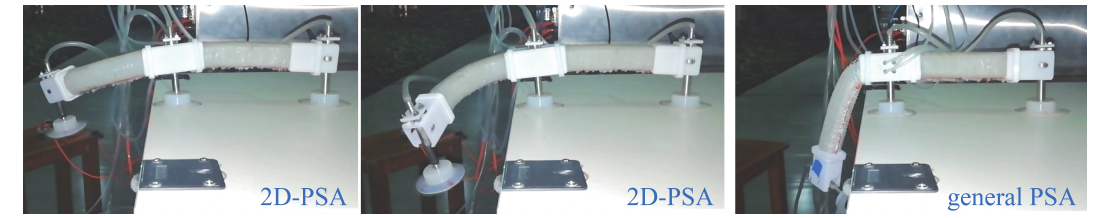
Figure 8. Difference in 2D performance between 2D-PSA and general